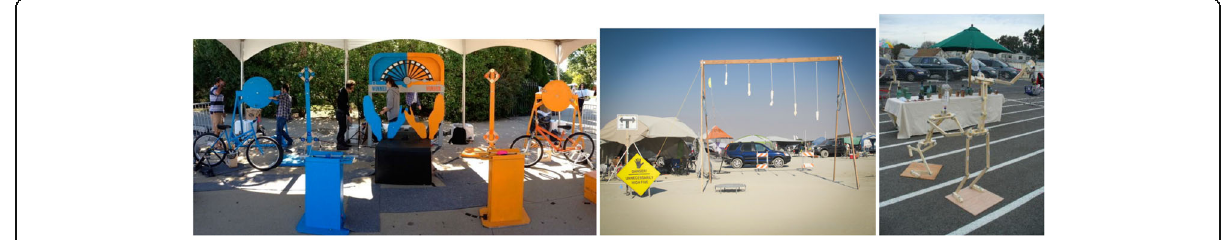
Fig. 5 Large-scale interactive artifacts of the Makers (Heather, Jack, and Mark,